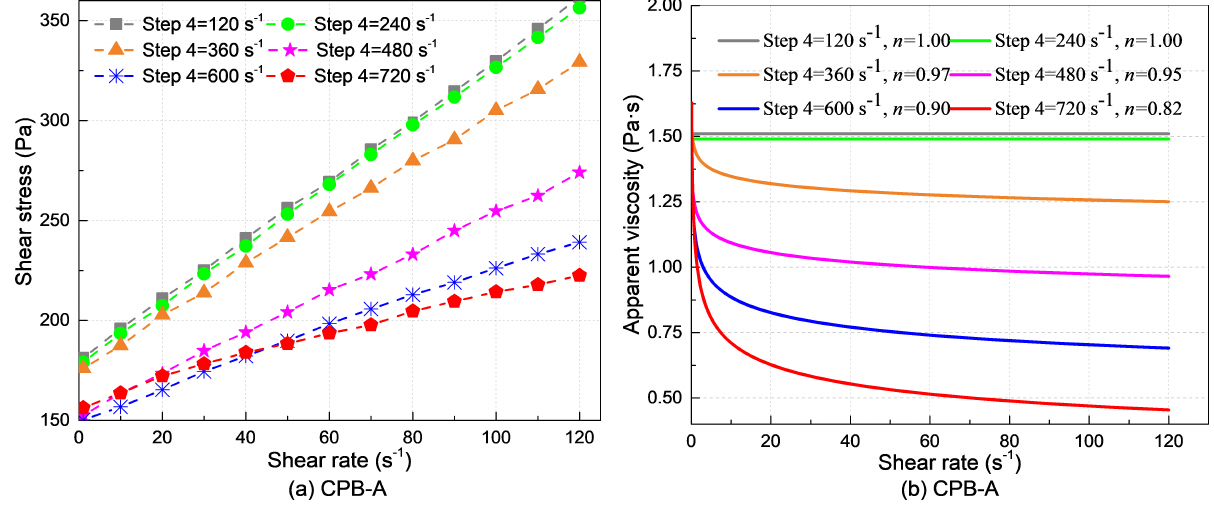
Figure 6: Effect of shear on flow curve behavior of